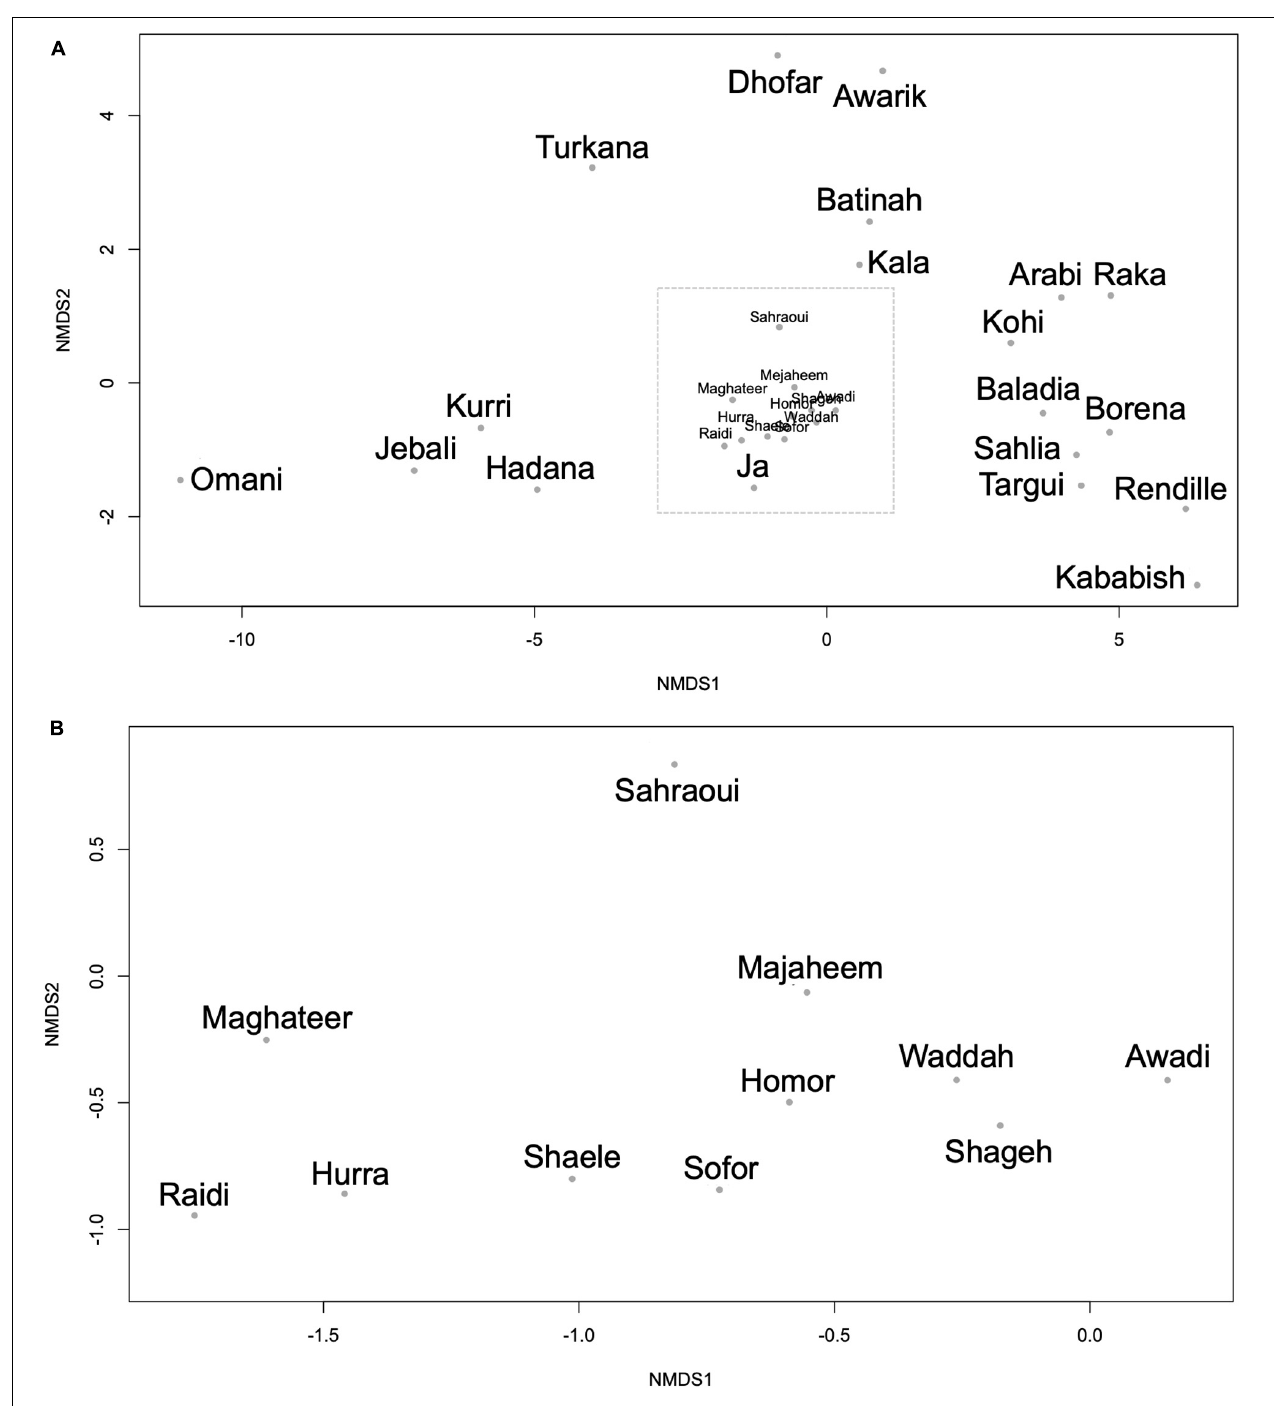
FIGURE 5 | Non-metric multidimensional scaling plot constructed using the F st values between each pair of the 30 camel-types. (A) All camel-types. (B) Expanded view of the camel-types enclosed in the dashed box in panel (A) . Each dot represents a camel-type.